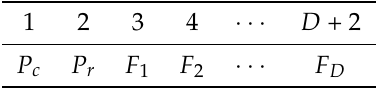
Table 1. The solution